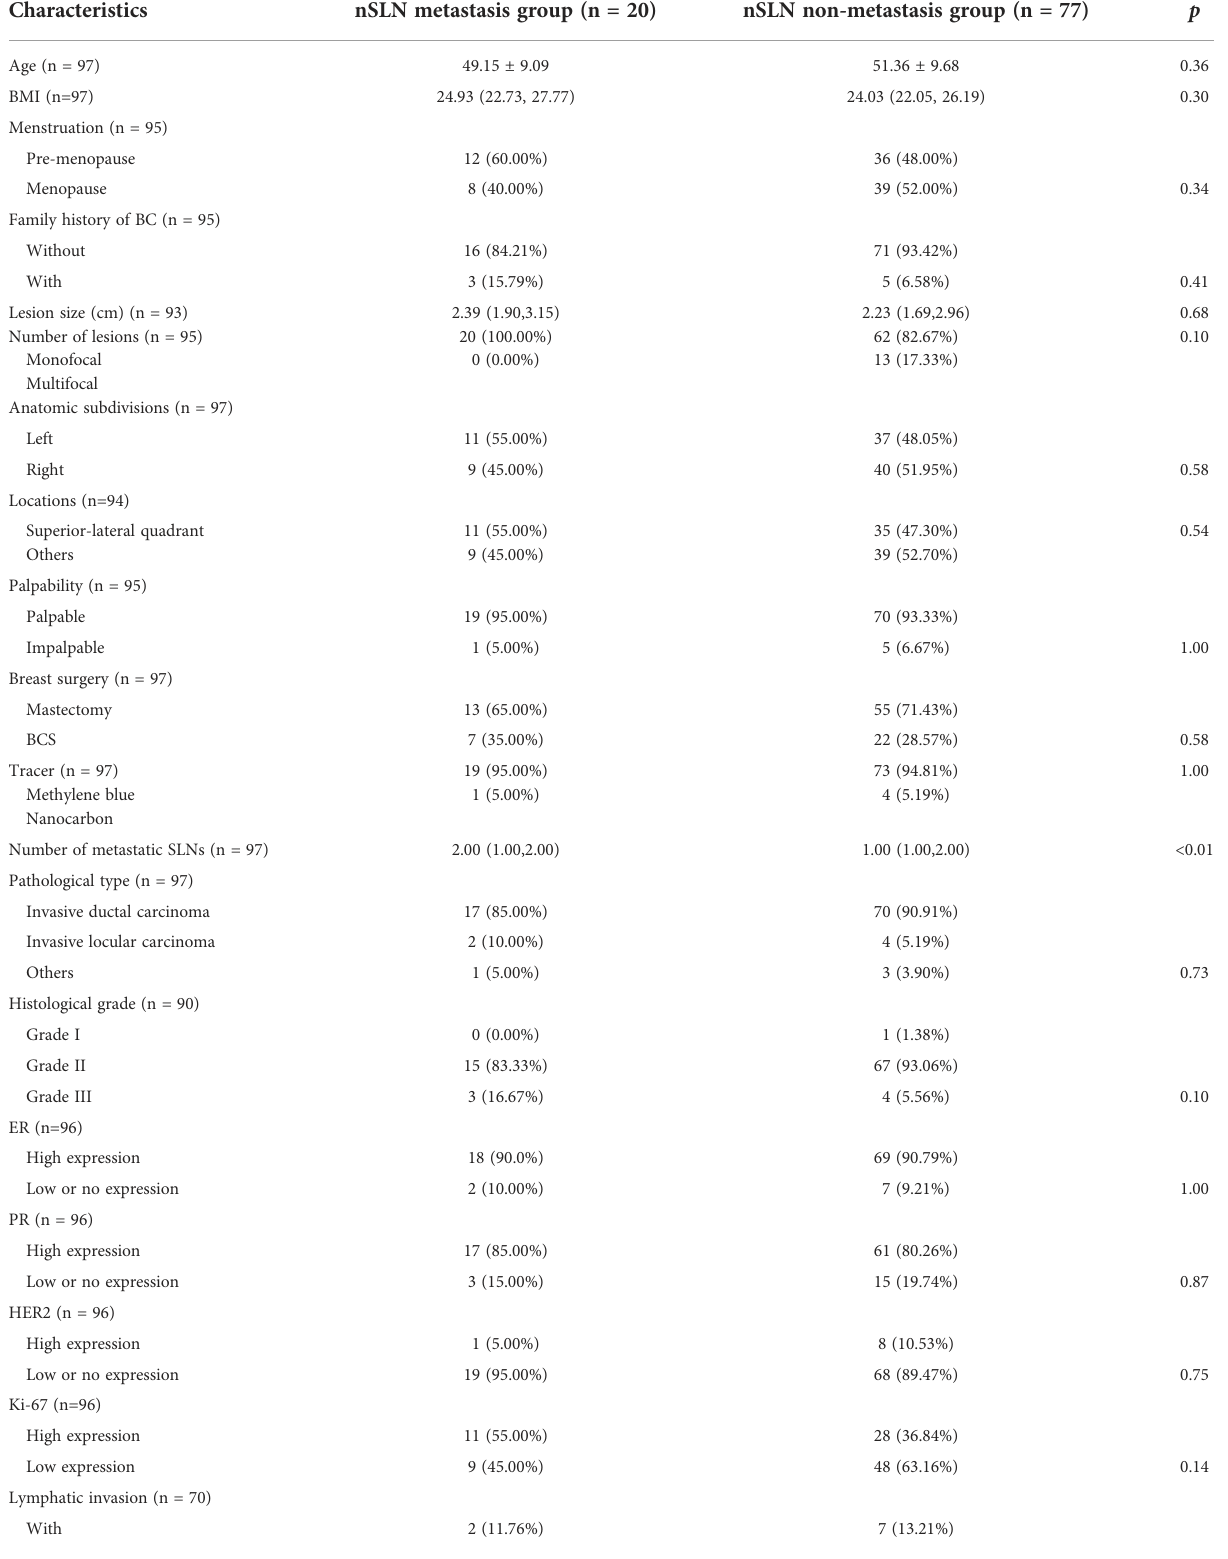
TABLE 3 Characteristics between nSLN metastasis and nSLN non-metastasis